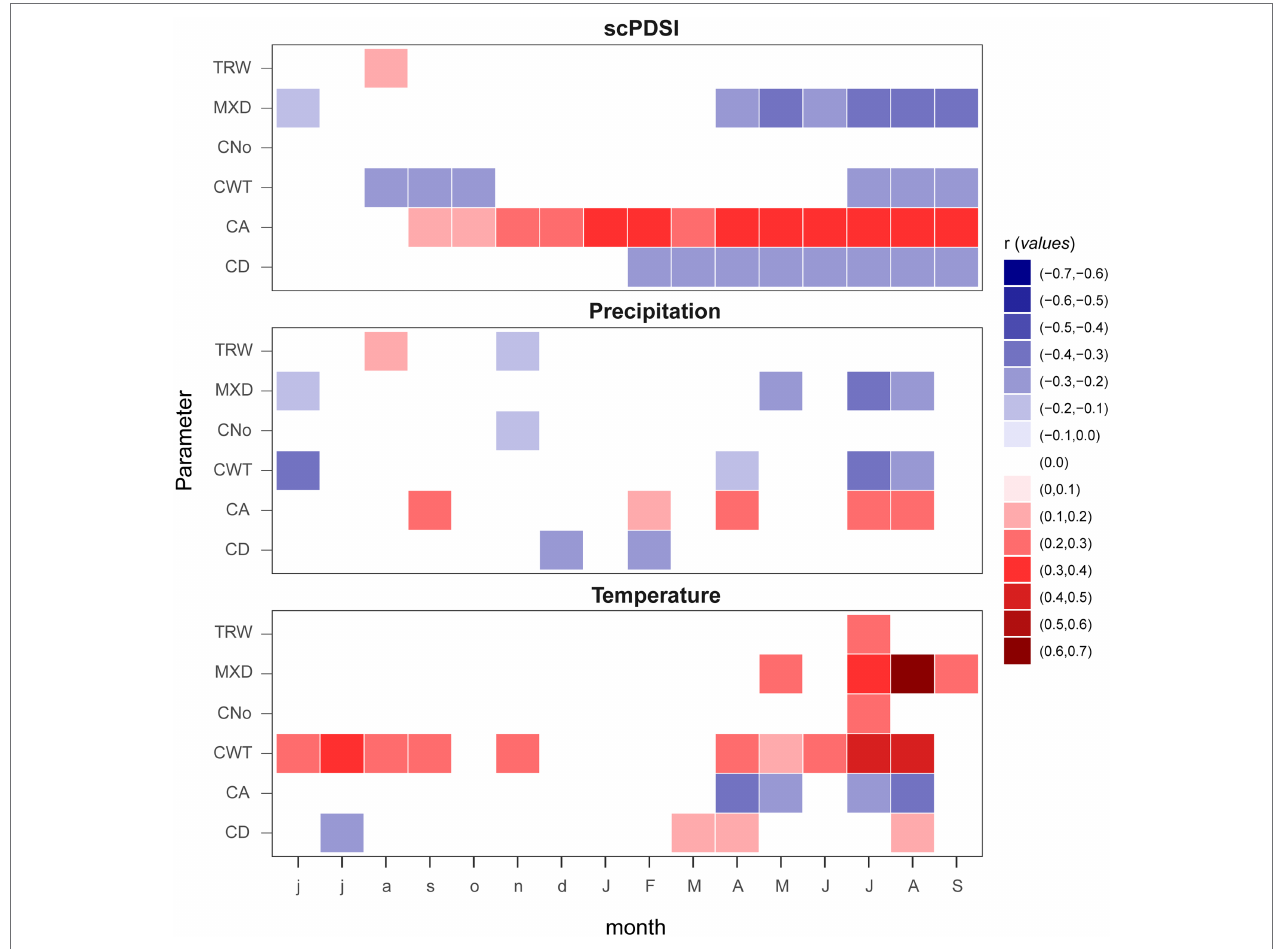
FIGURE 3 | Climate growth relationships computed between monthly climatic parameters (mean temperature, accumulation of precipitation, and scPDSI; from 1901 to 2015) and TRW, MXD, and anatomical parameters (CA, CNo, CD, and CWT). Lower case letters show the previous year and capitalized the current